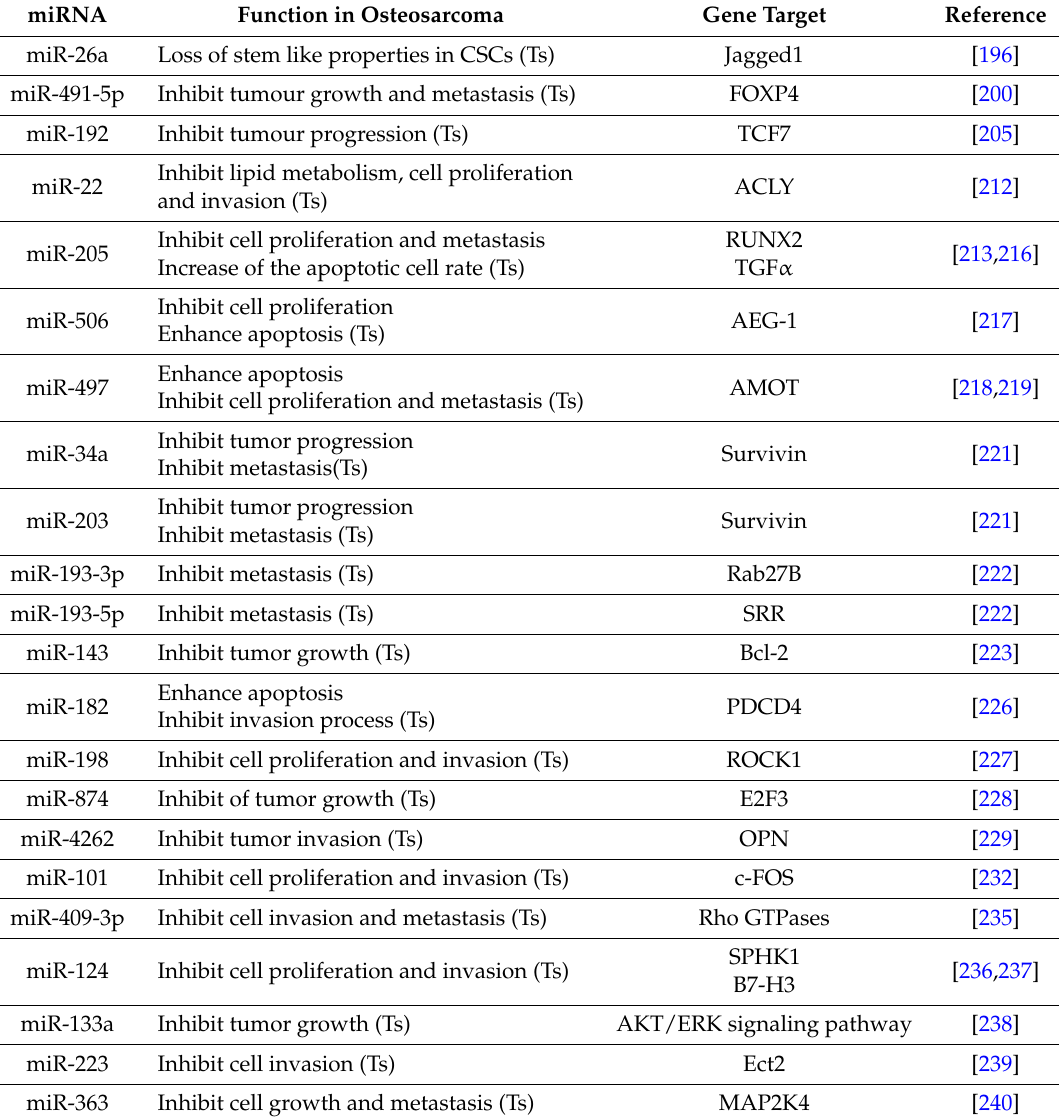
Table 4. Latest discovered cancer related tumor suppressors miRs in